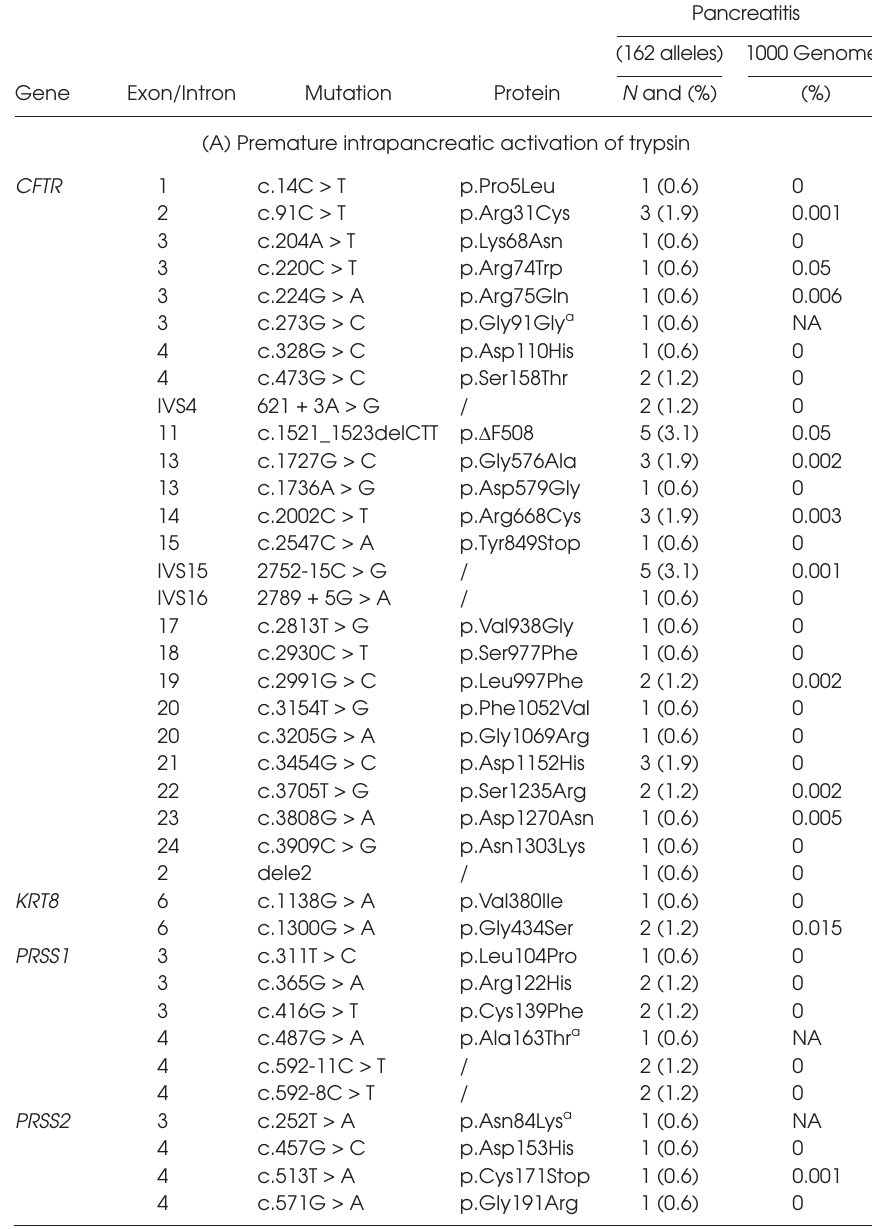
Pancreatitis (162 alleles) 1000